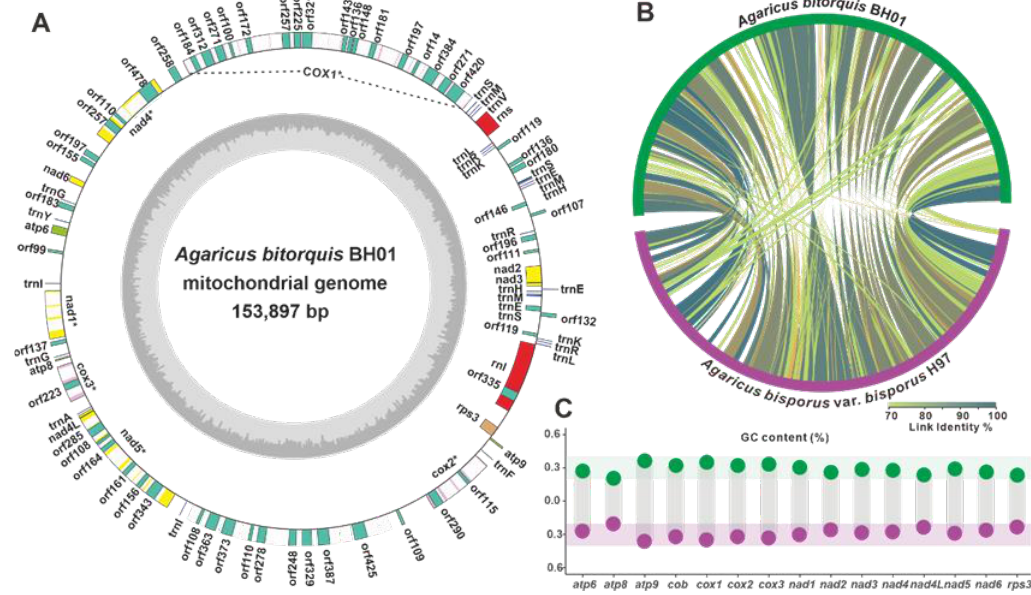
Figure 6. Mitogenome of A. bitorquis BH01 and its comparative analyses. ( A ) Circular map of A. bitorquis BH01 mitogenome. ( B ) Genomic collinearity analysis. ( C ) GC content comparison of 15 PCGs between A. bitorquis BH01 and A. bisporus var. bisporus H97.